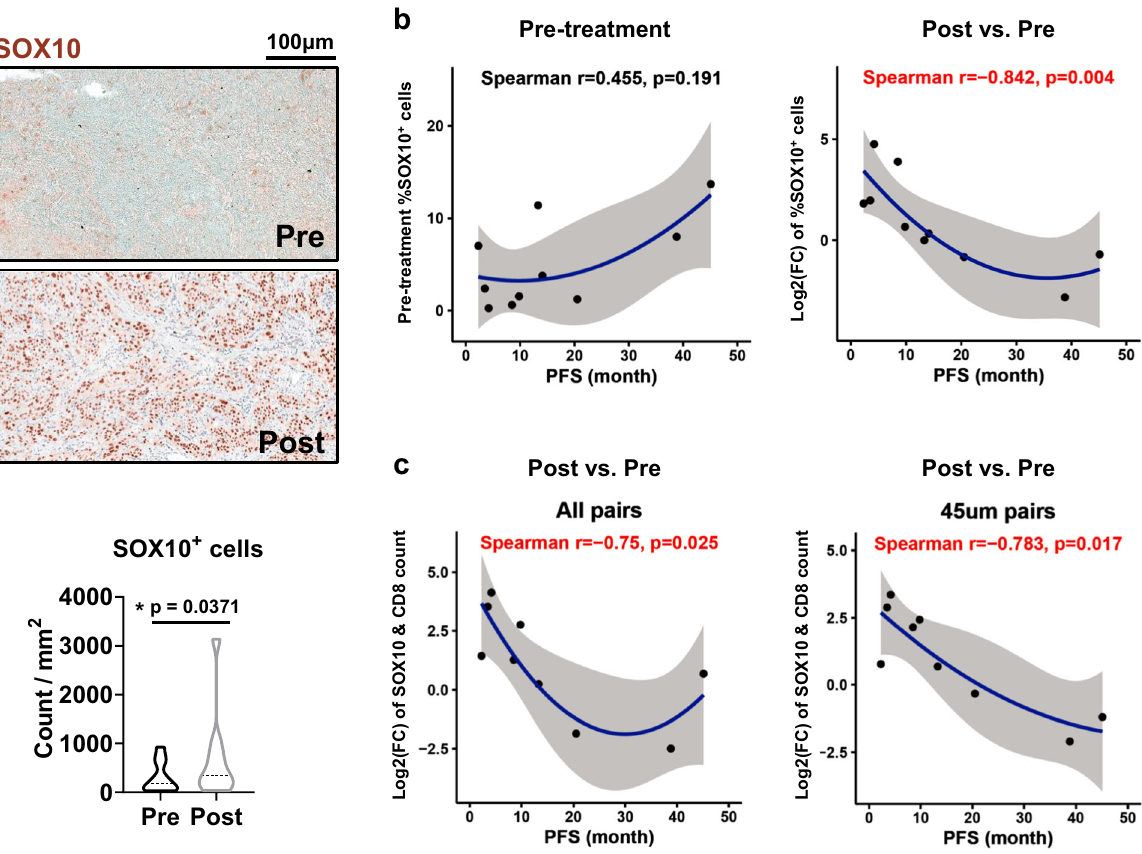
Fig. 2 Close association of SOX10 + melanoma cells with CD8 + cells negatively correlated with the PFS of patients treated with BRAF/ MEK-targeted therapy. Paired advanced melanoma samples from 11 patients (pre- and post-treatment of BRAF-targeted therapy) were analyzed. a Representative images and the violin plot of (SOX10 + ) melanoma cell count per mm 2 in tumors with Wilcoxon signed-rank test. b , c Scatter plots for the association between variables were shown with Spearman ’ s rank correlation test, a quadratic regression line WITH its 95% CI. b Frequency (%) was normalized to the count of all nucleated cells in each tumor. c The number of paired SOX10 + melanoma cells within a distance of 45 μ m of a CD8 + cell, or in reference to any distance, was normalized to the number of CD8 + cells in each tumor. The log2- converted fold-change (FC) values were used to measure changes in progressed tumors compared to tumors prior to Several mechanisms have been reported to suppress effector T-cell responses via co-inhibitory molecule interaction with melanoma cells, including PD-L1:PD-1 12 , CTLA-4:B7-1/2 13 , LSEC- tin:LAG-3 14 , CD155:TIGIT 15 , etc. Using the YUMM3.3 (BRAF mut ) melanoma model in C57BL/6 mice, we found that ~30% of CD45 − cells, including melanoma cells, are PD-L1 + , while ~80% of CD8 + T cells are PD-1 + in the tumor microenvironment (TME) (Supplementary Fig. 7a). Two weeks of anti-PD-1 treatment resulted in a signi fi cant (>50%) inhibition of tumor growth (Supplementary Fig. 7b). Anti-PD-1 treatment does not alter the frequency of total CD45 + leukocytes, total CD3 + T cells, or CD8 + T cells in the TME (Supplementary Fig. 7c). However, while ~10% of CD8 + T cells are activated (CD69 + ) in the tumors treated with isotype control IgG, anti-PD-1 treatment increased the frequency of activated CD8 + T cells to ~40% in the TME (Supplementary Fig. 7c). These data con fi rmed the detrimental role of the PD-L1:PD-1 axis between melanoma cell:Tc-cell in melanoma. In this retrospective study, we performed MxIHC and subse- quent whole-tumor imaging spatial analyses of tumors obtained from 11 melanoma patients prior to BRAF/MEK-targeted therapy and after the disease progressed. The data revealed that at the time of progression, the close association of SOX10 + melanoma cells with CD8 + T cells negatively correlated with PFS of melanoma patients and may indicate a potential mechanism for acquired resistance to BRAF/MEK-targeted therapy. The observed